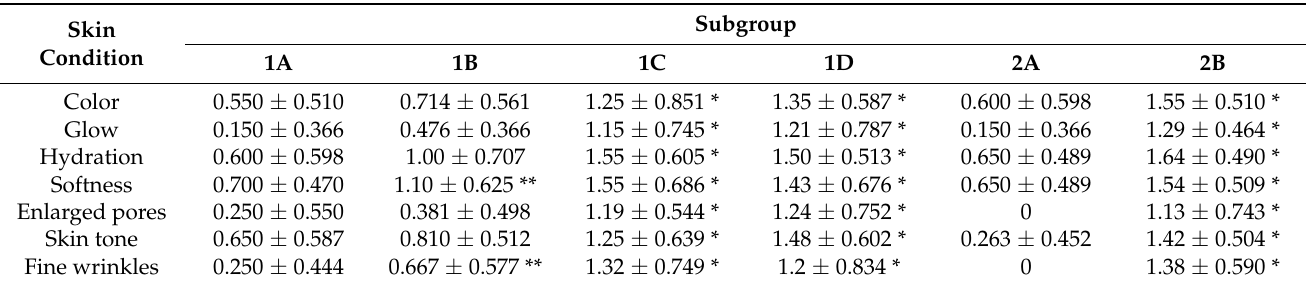
Table 5. The results of the survey of patients on the scale of changes in the condition of the skin, in points (M ± SD).